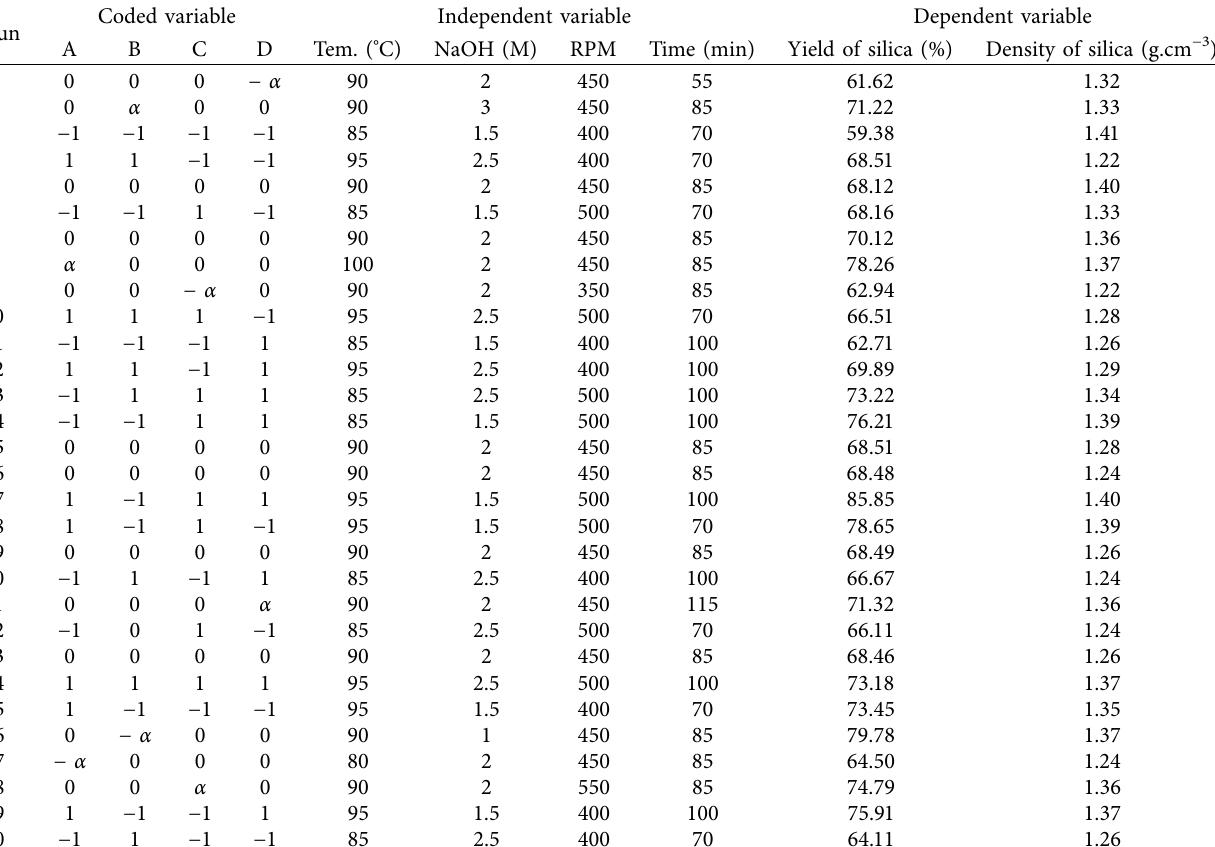
Table 2: Experimental results of silica yield